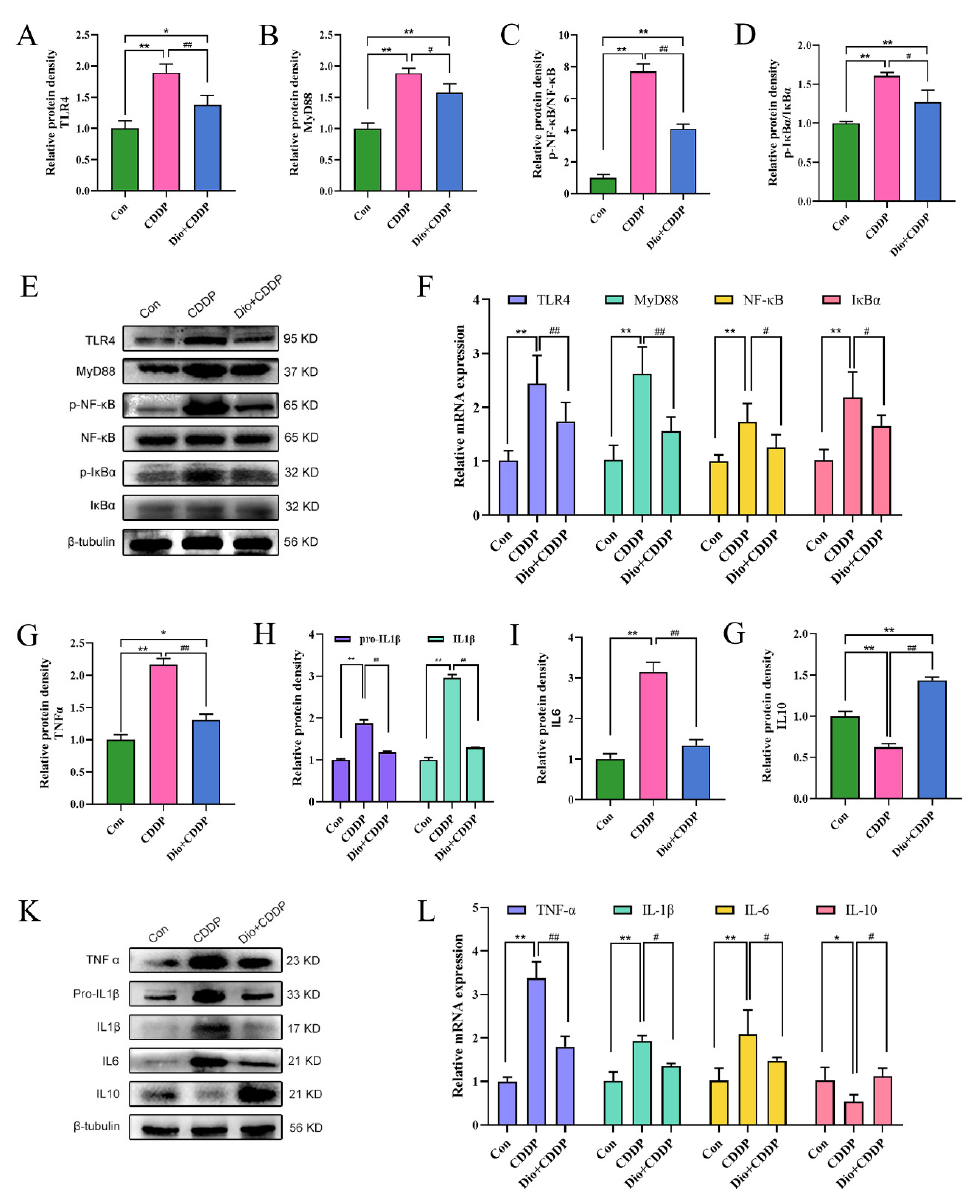
Figure 5. Effect of Dio on the activation of TLR4-MyD88-NF- κ B signaling pathway and immune- inflammation status in rats with CDDP-induced mucositis. Changes in the relative protein expression levels of TLR4 ( A ), MyD88 ( B ), p-NF- κ B/NF- κ B ratio ( C ) and p-I κ B α /I κ B α ratio ( D ). ( E ) Representative Western blotting images of TLR4, MyD88, p-NF- κ B, NF- κ B, p-I κ B α and I κ B α . ( F ) Relative mRNA expression of TLR4, MyD88, NF- κ B and I κ B α . Changes in the relative protein expression levels of TNF α ( G ), Pro-IL1 β & IL1 β ( H ), IL6 (I) and IL10 ( J ). ( K ) Representative Western blotting images of TNF α , Pro-IL1 β , IL1 β , IL6 and IL10. ( L ) Relative mRNA expression of TNF- α , IL-1 β , IL-6 and IL-10. * p < 0.05, ** p < 0.01 vs. control group, # p < 0.05, ## p < 0.01 vs. CDDP group.